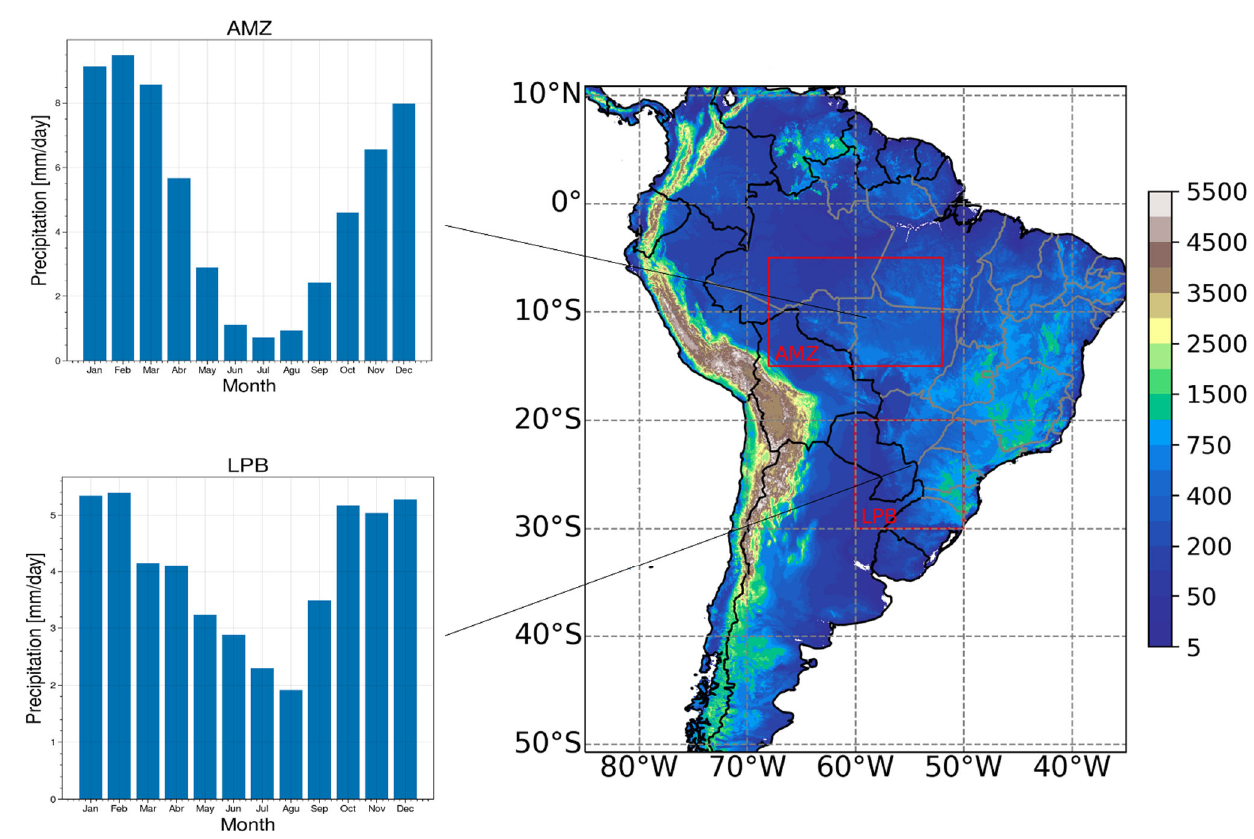
Figure 1. Study area (with topography in meters) and the subdomains (red boxes) located at the main hydrological basins—the Amazon and La Plata basins—with the annual mean cycle of precipitation (1995–2014) obtained from CPC. Topography source: United States Geological Survey—Earth Resources Observation System (EROS) Center.